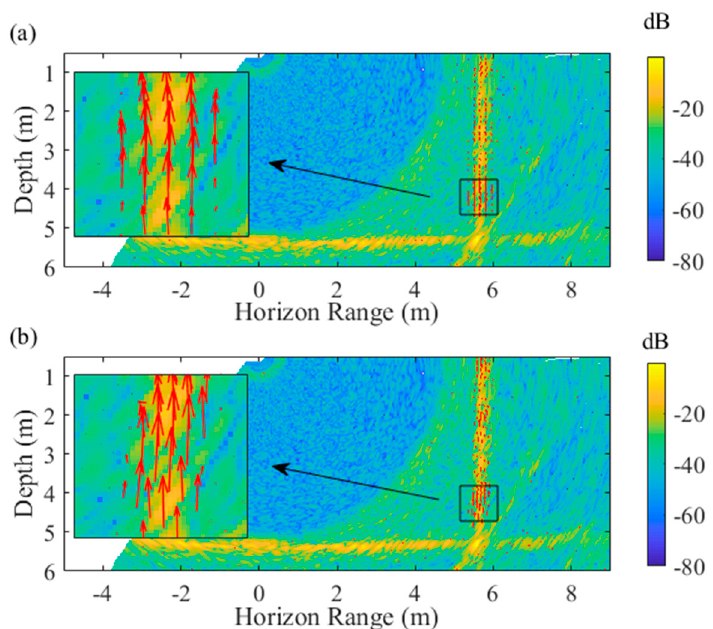
Figure 7. The joint display of the WCI and velocity field estimated by frame A ( a ) and frame B ( b ), respectively. The fixed nozzle aperture is φ = 0.6 mm and the output intensity of pressure and the output flow rate was 0.1 MPa and 6.3 L/min, respectively.